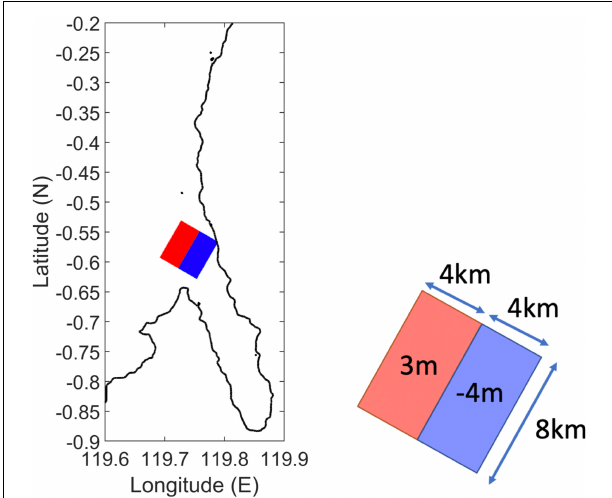
FIGURE 5 | The initial free surface elevation for the proposed potential submarine landslide tsunami off the mouth of Palu Bay. The color shading indicates the water surface disturbances by the landslide: red – the uplift of the water surface disturbance; blue – the depression of the water level disturbance. The dimension of the initial free surface elevation is shown in the right